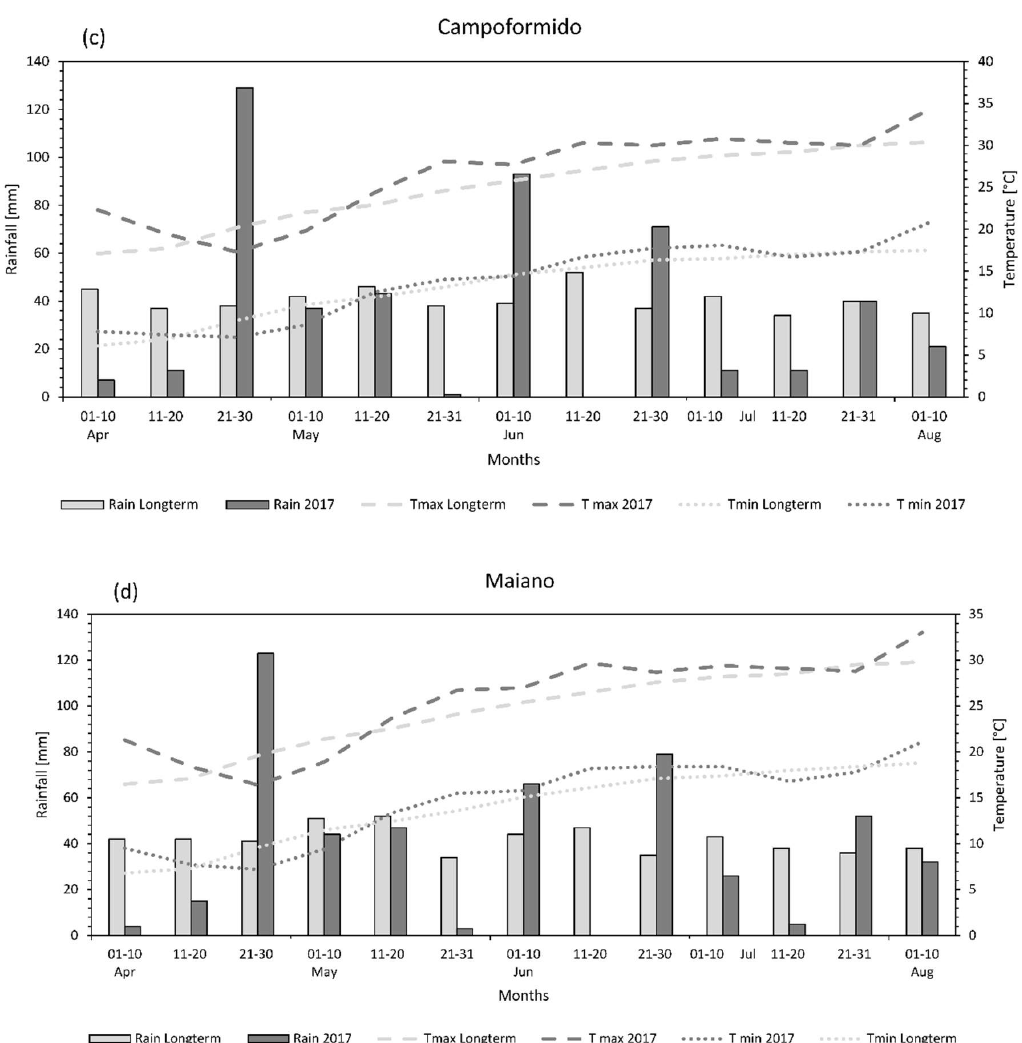
Figure 1. Ten days maximum average temperature (T max), minimum average temperature (T min) and total rainfall during the growing season in Udine ( a ) during 2016, Aviano ( b ), Campoformido ( c ) and Maiano ( d ) during 2017. Long-term values were the 25-year average.